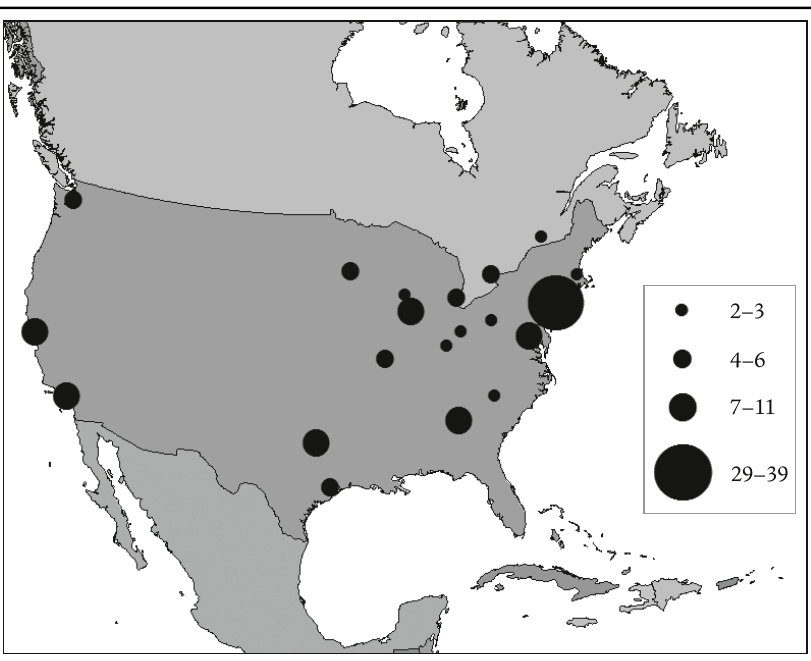
Figure 5 – Headquarter Location of Fortune Global 500: North America,